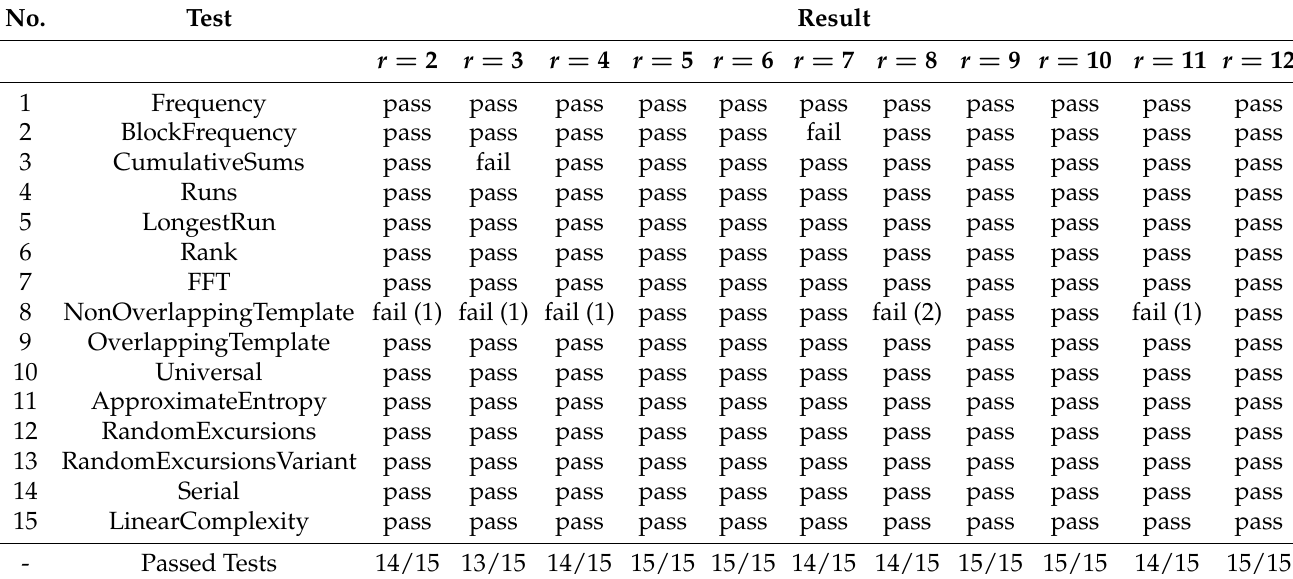
Table A2. NIST test results for (33) using map (25) ( x 0 = 0.1, k = 10, a =